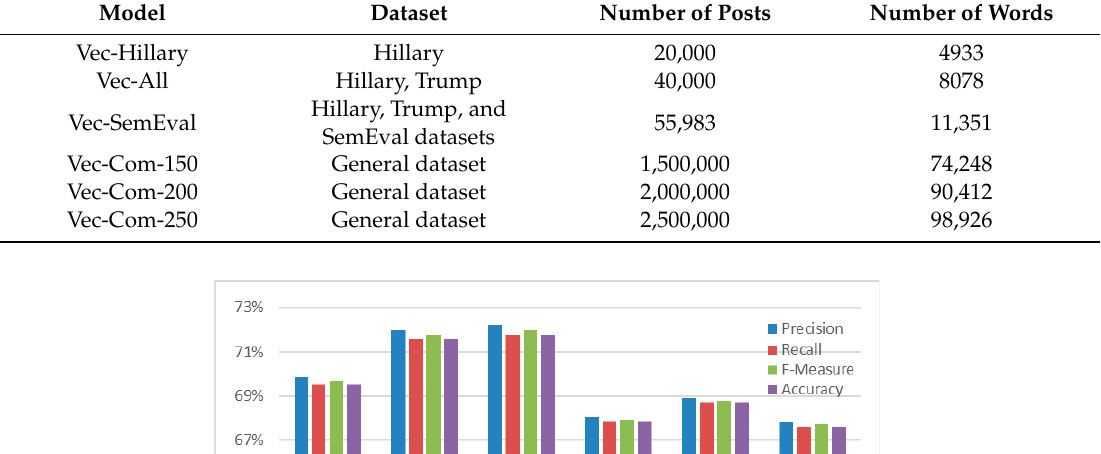
Figure 3. The performance of sentiment classification using different Word2Vec models. Table 1. Datasets for training word embedding models for sentiment classification.